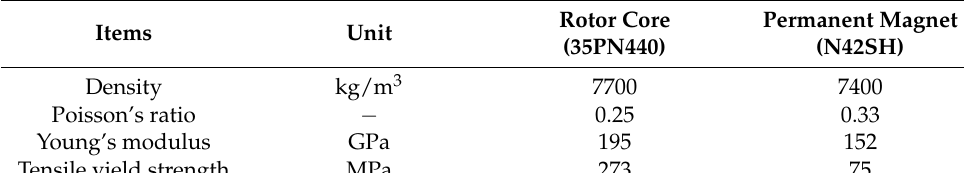
Table 5. Material properties for mechanical stress analysis.